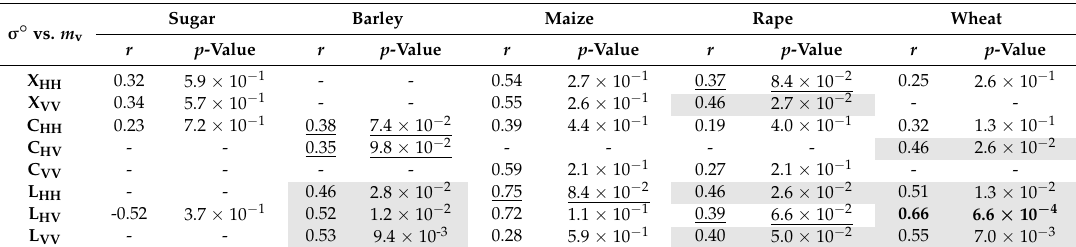
Table 4. r of σ ◦ vs. m v for plots covered by vegetation. Quasi -significant correlations